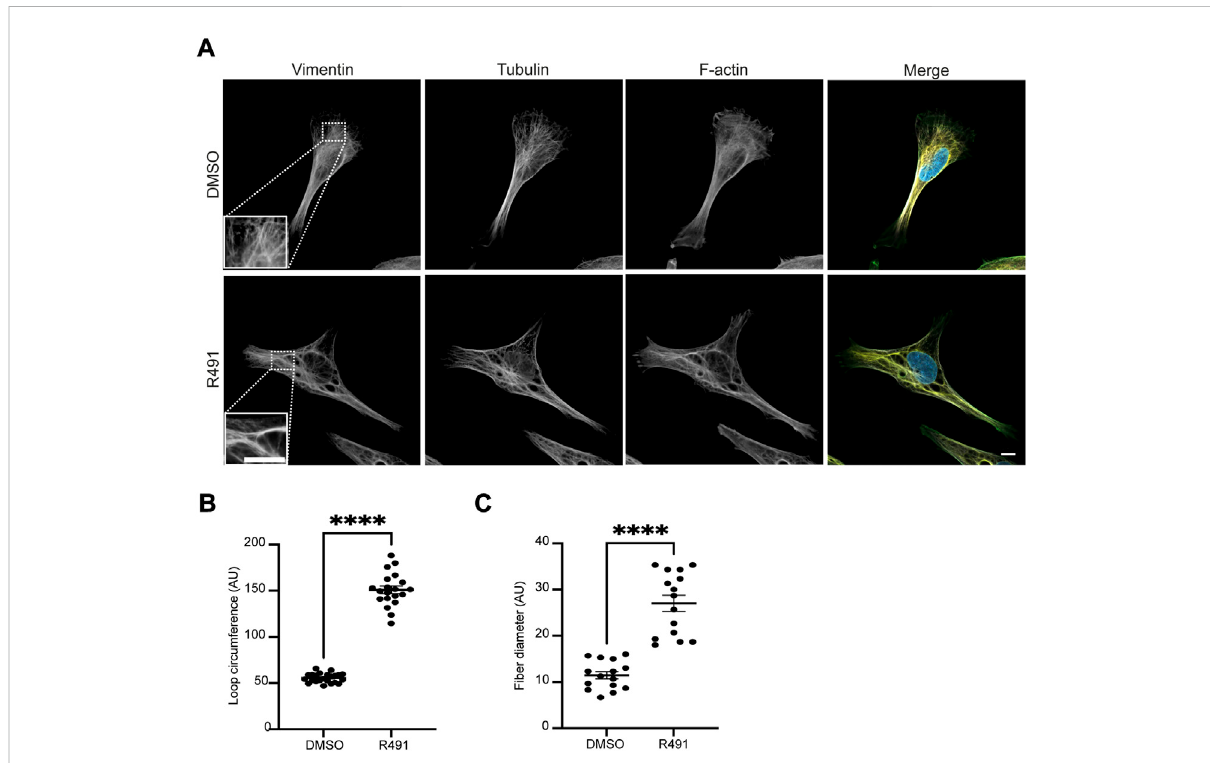
FIGURE 1 R491-treatment changes the spatial organization of vimentin fi laments. (A) Representative images of BJ-Ras-cells with 5 μ M control (top) or R491 (lower panel), showing vimentin, microtubule and actin, as indicated, and merged images of vimentin (red), F-actin (green), tubulin (white) and nuclei(blue).Insetimages:magni fi edviewsofboxedareasincorrespondingimages.Scalebars:10 μ m.Thegraphsshowthequanti fi cationof (B) the loop circumferences ofvimentin fi laments in DMSO ( n =23) and R491-treated ( n =20)cells, and (C) thediameter of fi laments inDMSO ( n = 15) and R491-treated (n = 15) cells. **** p ≤ 0.0001. AU: arbitrary unit. Data presented as mean ±